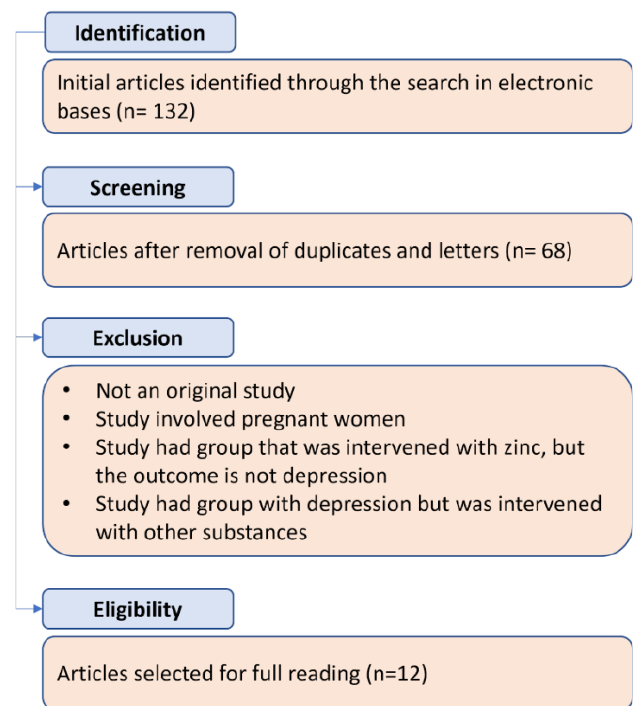
Figure 1 Scheme of article’s